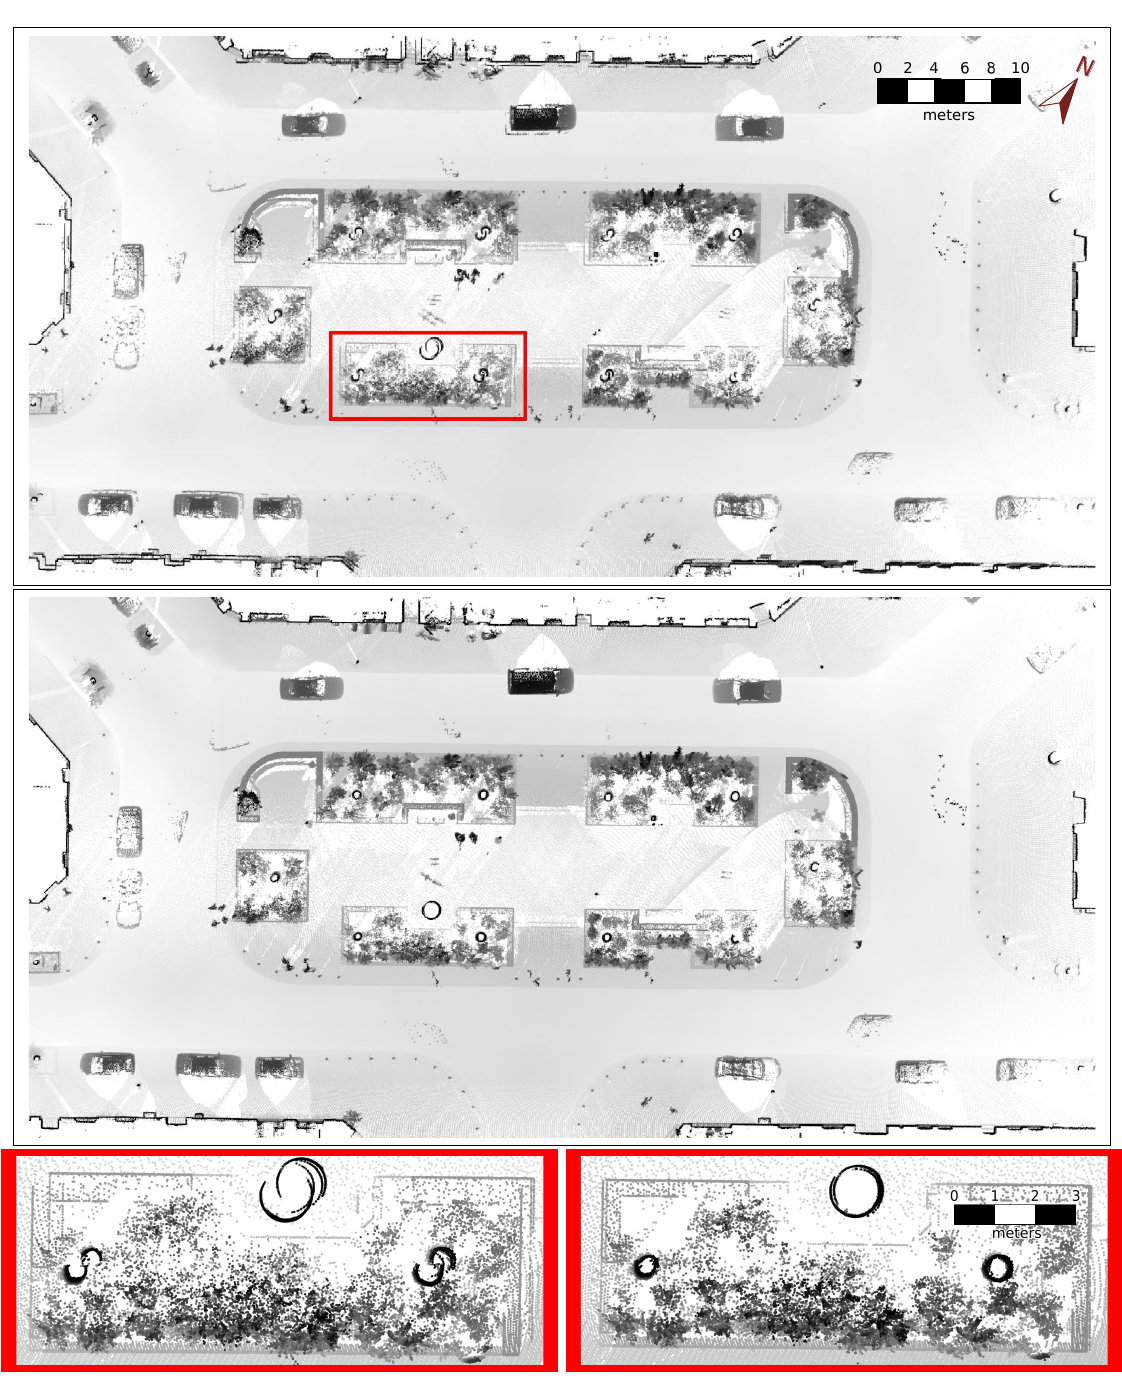
Figure 15. A small loop in Dortmund 1 (Germany) as acquired by the Lynx Mobile Mapper ( Top ) and after the semi-rigid optimization has been applied ( Center ). In the bottom, a more detailed view on the park with an advertising column and two trees initially ( Left ) and after optimization ( Right